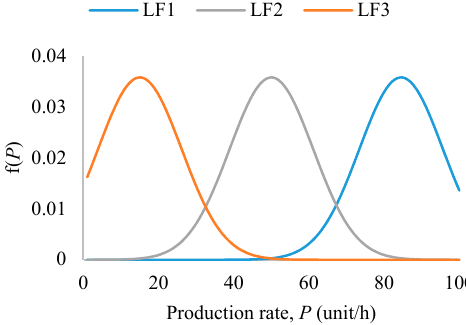
Figure 2. Load factors considered in the numerical analysis.